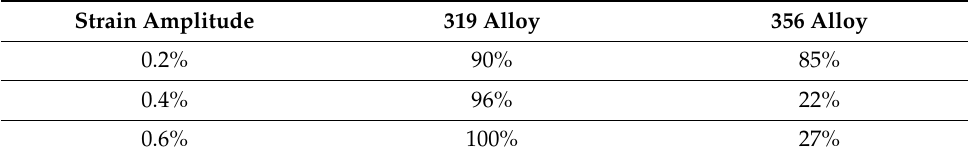
Table 3. Proportion of stage I in total TMF lifetimes of experimental alloys. Strain Amplitude